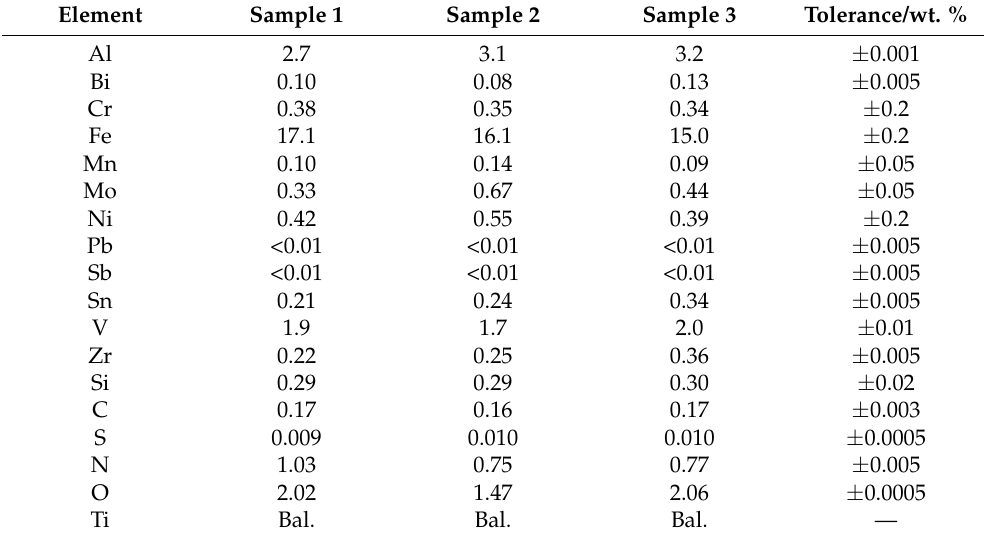
Table 2. Chemical compositions of the randomly selected samples of FeTi-cored wire (in wt. %).